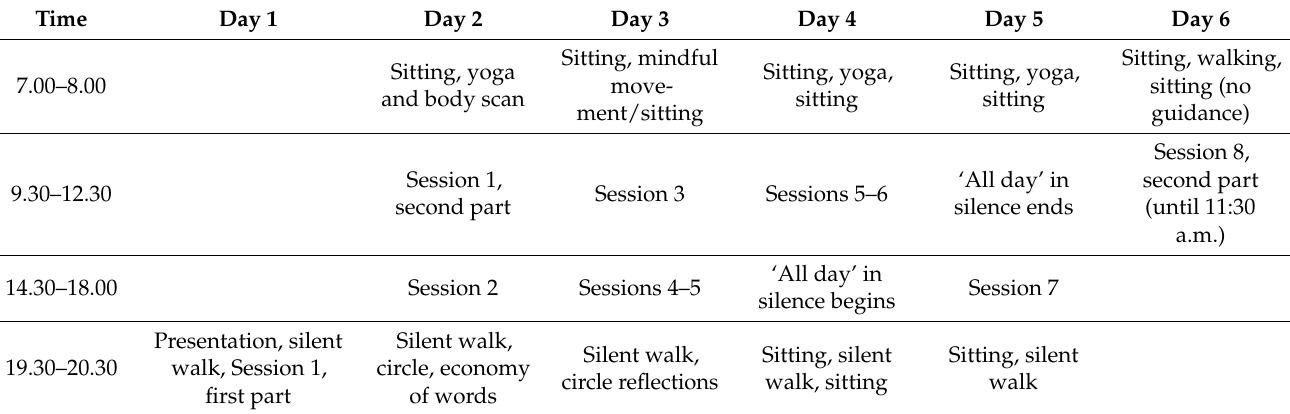
Table 1. Programme for both intervention groups.